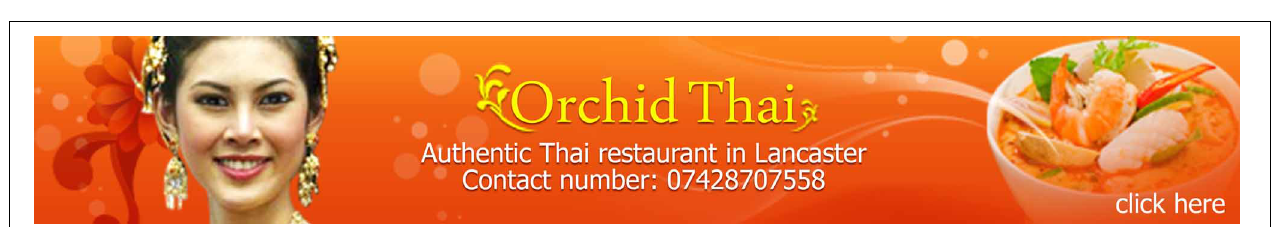
FIGURE 6 | Fabricated horizontal banner advertisement for “Orchid Thai” in the no face condition.